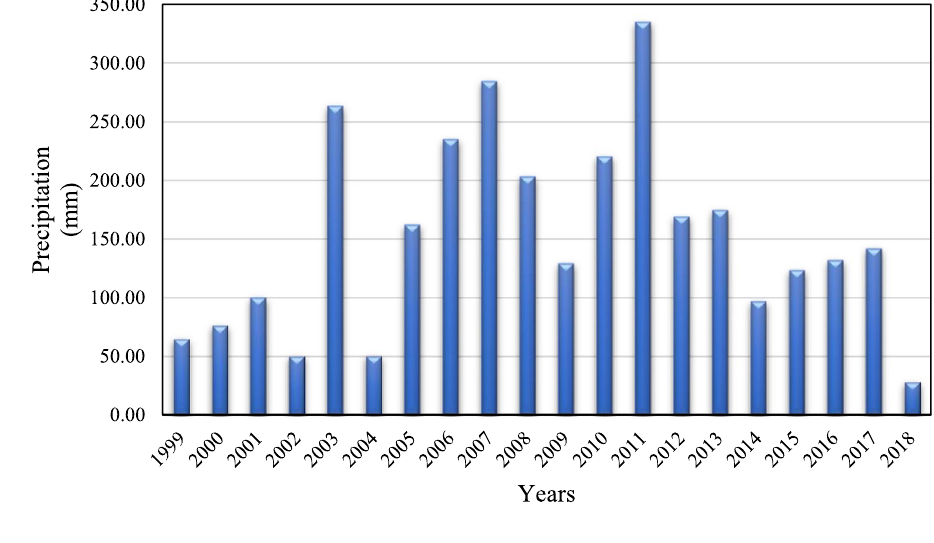
Fig. 4 Annual amount